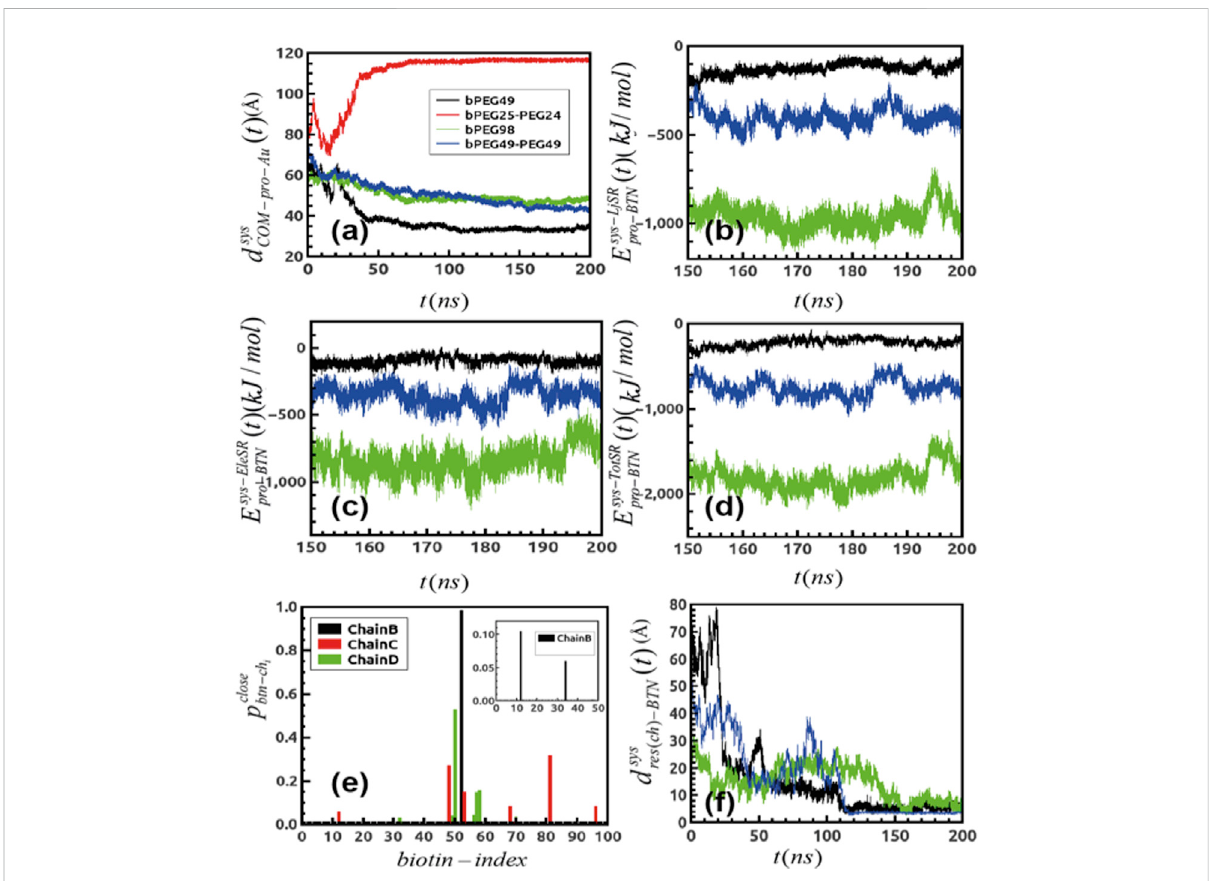
FIGURE 2 (A) Distance fl uctuation betweenthecenter ofmassof proteinover thegoldsurfacefor differently functionalized surfaces. (B) Short-rangedLJ interactionbetweenproteinandallthebiotinsgeneratedovertrajectoriesandthatfor (C) short-rangedelectrostaticcomponents (D) and fi nally,the totaladditive bindingenergeticsfor thesystems;black: bPEG49, green: bPEG98, and blue:bPEG49-PEG49. (E) Probability of fi ndingbiotins closeto binding loops of Streptavidin for different chains of bPEG98 and same for bPEg49-Peg49. (F) Distance fl uctuation between the terminal biotin atom and the residue of Streptavidin forming binding over MD. The color code is same as in Figures 2B −